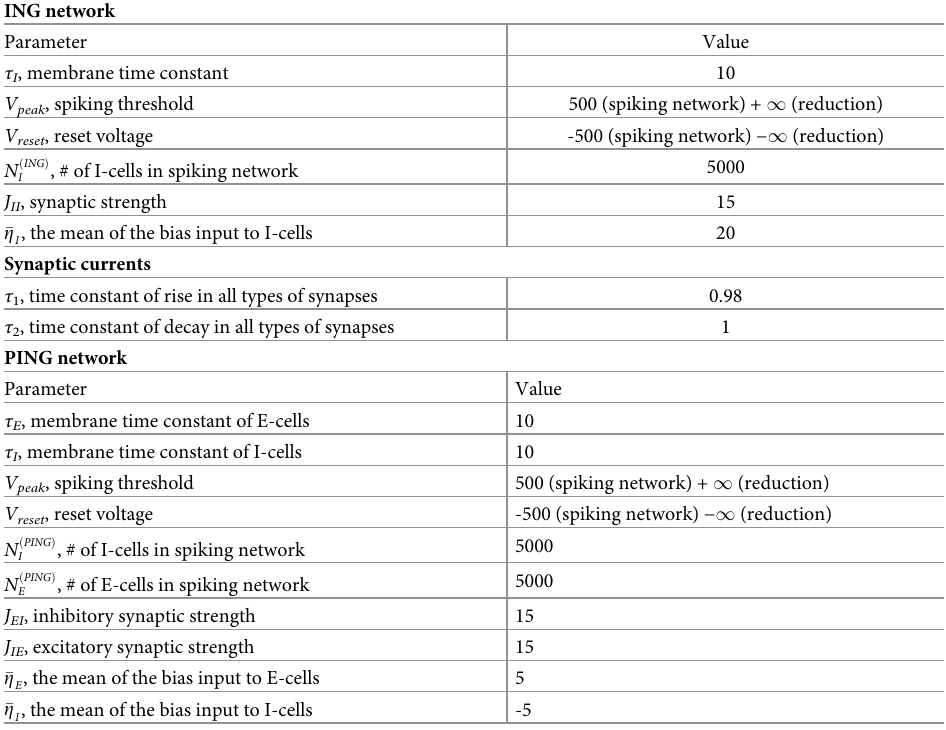
Table 2. Parameters used in the network model of QIF neurons and its eMFT reduction. Most parameters are based on [13, 27]. ING